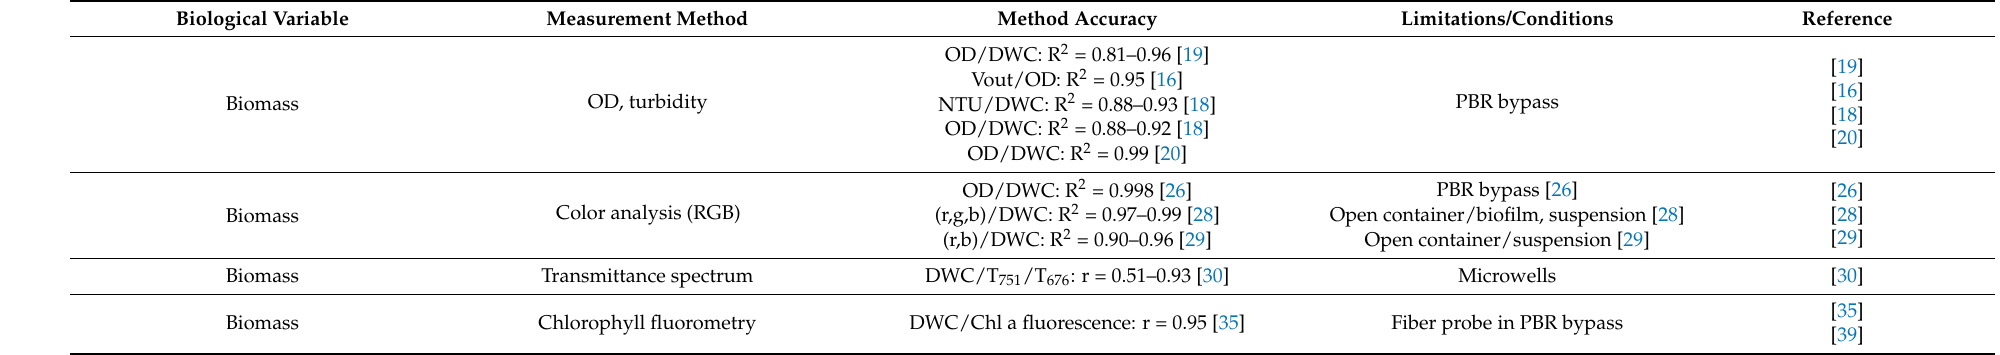
Table 2. Accuracy of the reviewed methods where available in the original article. Included are only methods not using software sensors; these are shown in Section 4. (DWC: dry weight concentration (of biomass); OD: optical density; V out : sensor output voltage; NTU: nephelometric turbidity unit; r, g, b: intensities of the red, green and blue components; T 751 , T 676 : transmittance at 751 and 676 nm; Chl a: chlorophyll a; CC: cell count; HR: hyperspectral reflectance; EC: extinction coefficient; OD 560 : optical density at 560 nm; ∆ ε : change in permittivity; QY: quantum yield; ISM: In-Situ Microscope; DHA: docosahexaenoic acid; R 2 : coefficient of determination; r: Pearson correlation